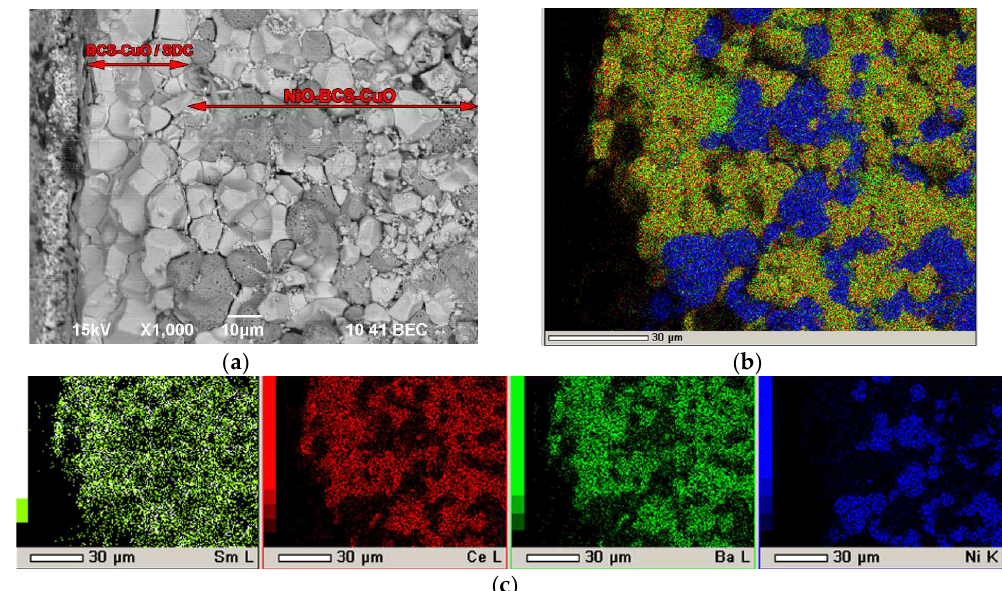
Figure 10. Fracture images of the BCS-4 sample with the BCS-CuO/SDC electrolyte layer on the NiO-BCS-CuO anode substrate (sintered at a temperature of 1450 °С for 5 h) after electrochemical testing in the SOFC mode: ( a ) SEM image, magnification х1500; ( b ) integral map of the elements’ distribution; ( c ) individual elements’ maps.